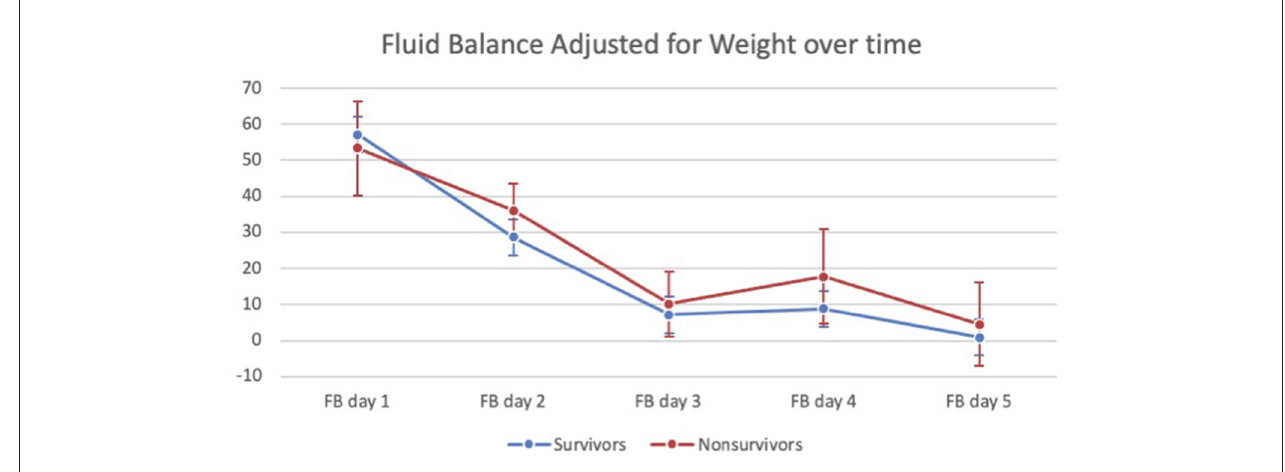
FIGURE 2 | Fluid balance (adjusted for patient weight) in survivors vs. non-survivors over the first 5 days of ECMO.